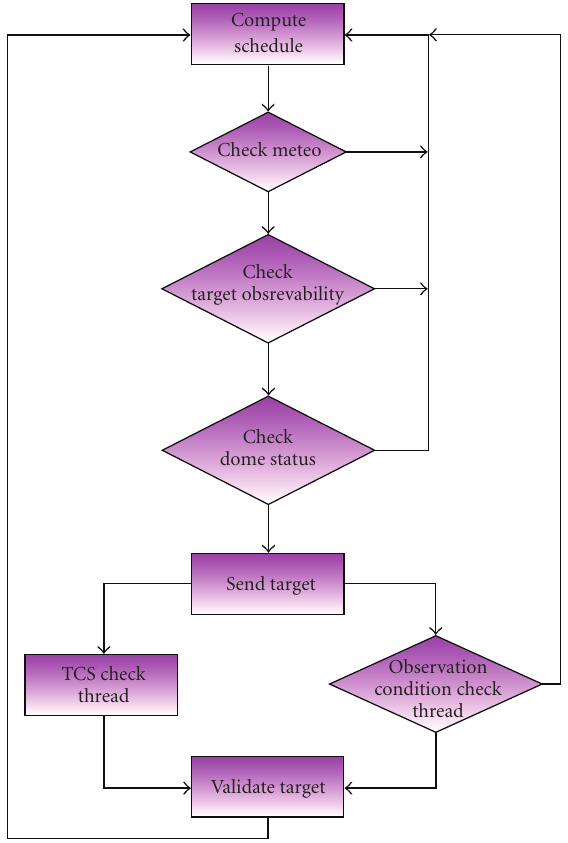
Figure 2: Flux diagram of the main cycle of the observation